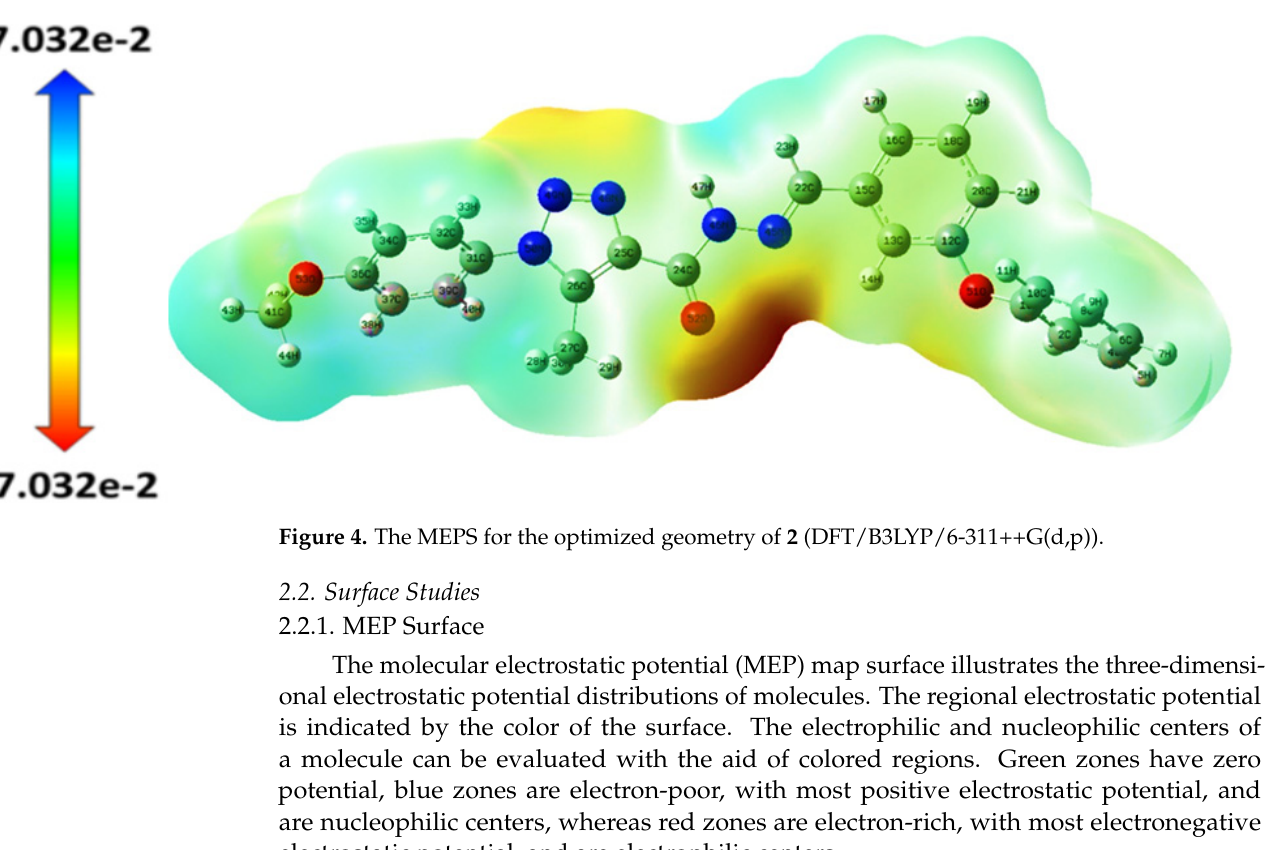
Figure 4. The MEPS for the optimized geometry of 2 (DFT/B3LYP/6-311++G(d,p)).